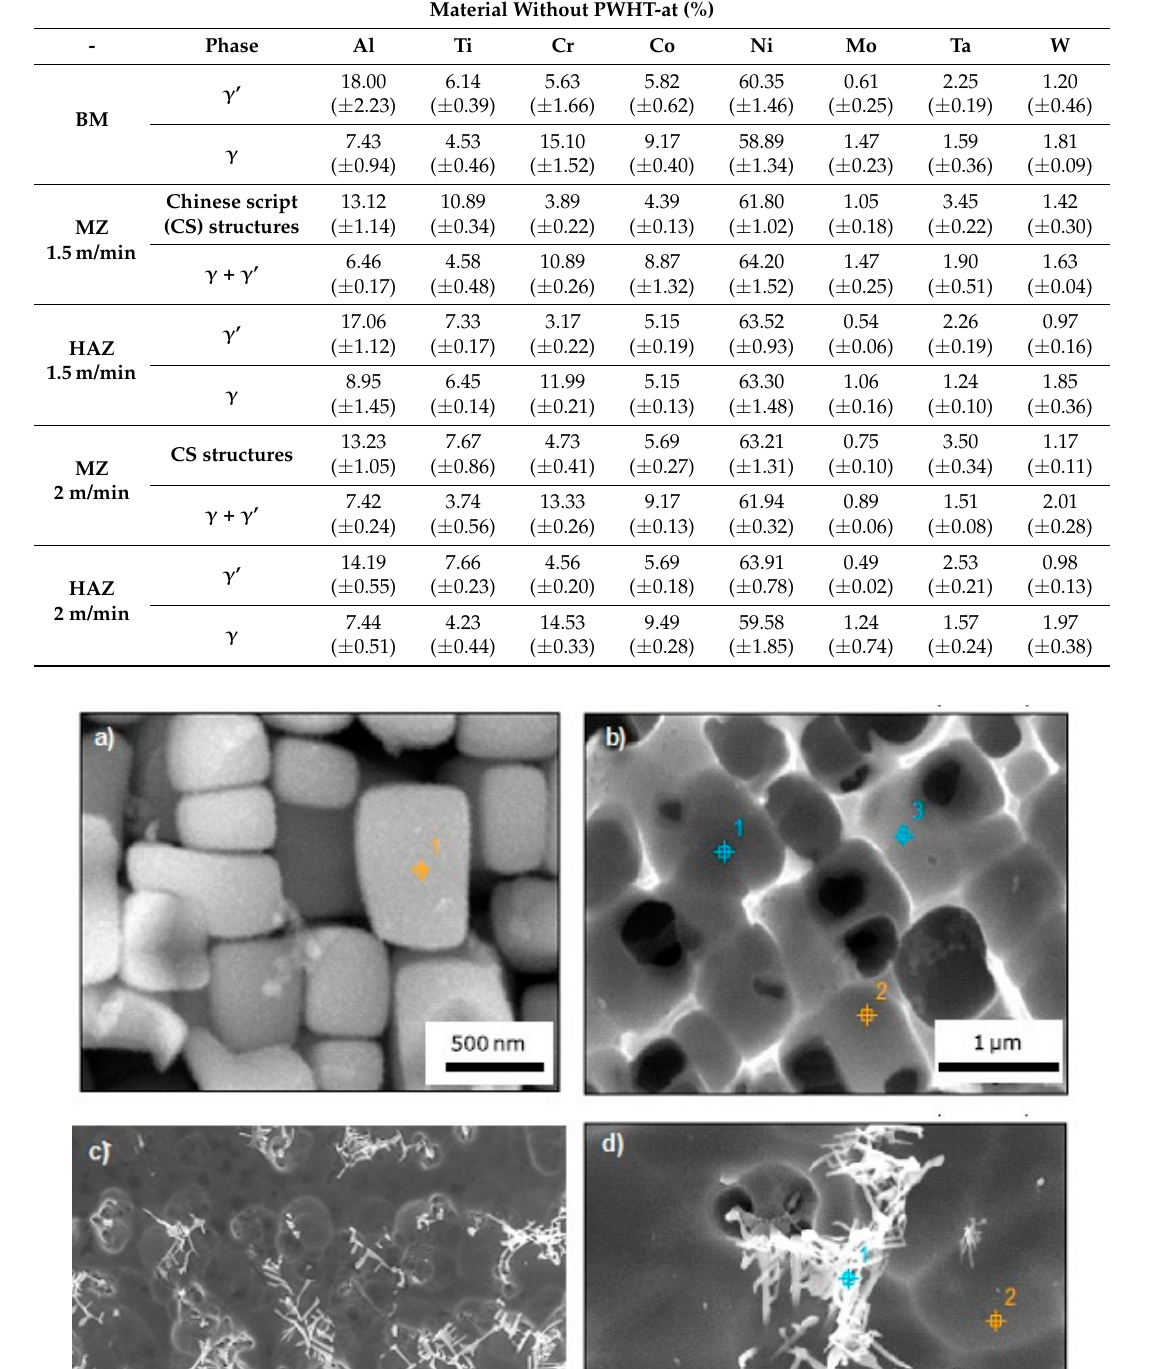
Table 4. EDS data determined on the phases of BM and of HAZ and MZ in EB joints. Material Without PWHT-at (%)